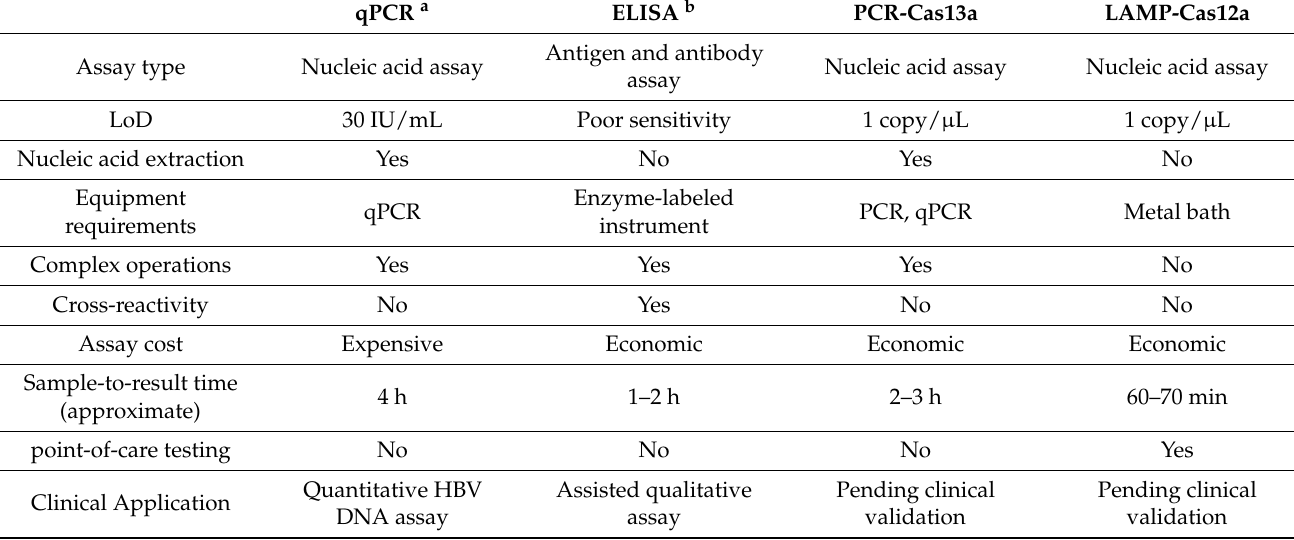
Table 2. Comparison of Ca12a-DETECTR assay with existing